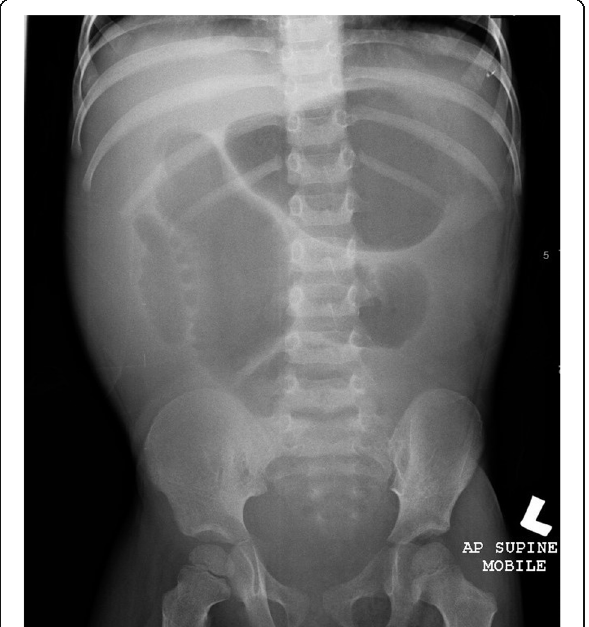
Fig. 2 Tubular structure passed out on day 6 of illness which resembled necrotic small